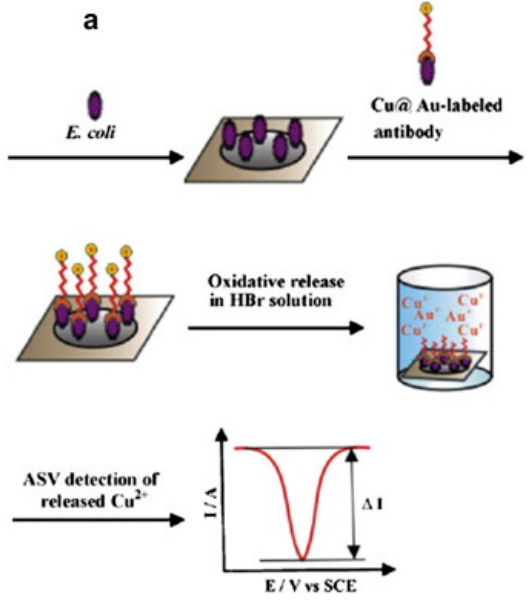
Figure 9. Steps of nanomaterial-based biosensing of pathogen. Table 3. Summary of various biosensors with their advantages and limitations.